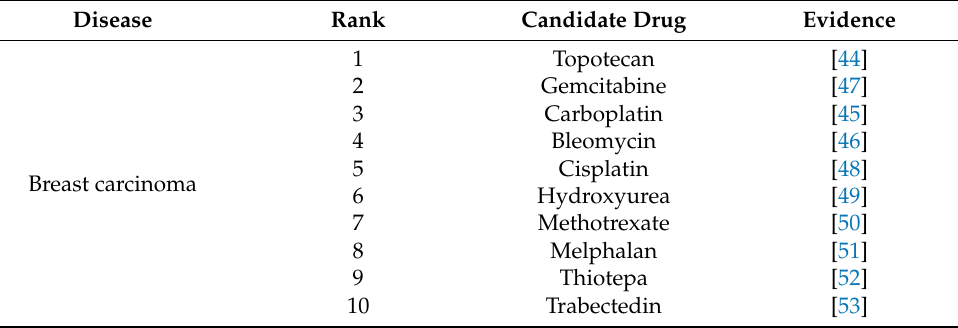
Table 4. Top 10 related drugs for breast carcinoma predicted by the EMPHCN. Disease Rank Candidate Drug Evidence 1 Topotecan [44] 2